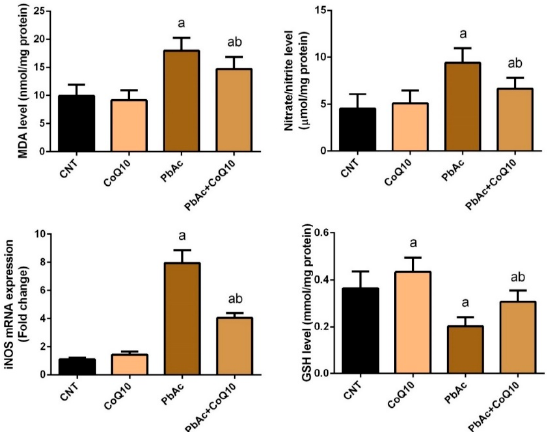
Figure 2. The beneficial effects of coenzyme Q10 on cortical lipid peroxidation and nitrate/nitrite and glutathione content following lead acetate exposure. Results represent the mean ± SD ( n = 7); significant changes at P < 0.05 were determined using Duncan’s post-hoc test. a significant change compared with the control group; b significant change compared with the PbAc injected group.